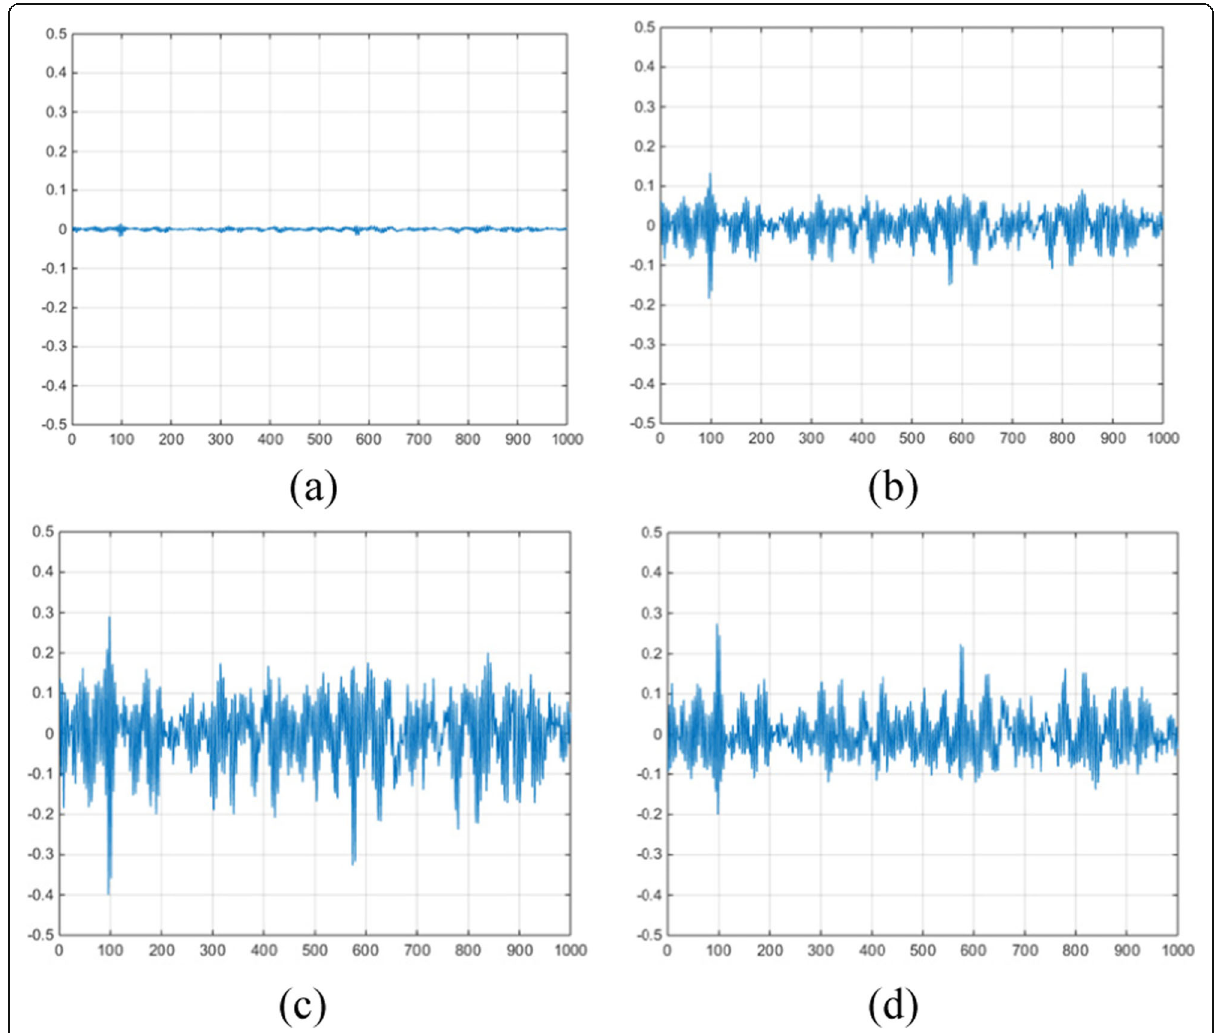
Fig. 5 Output signal at each beam-scanning grid (elevation, azimuth): a (10°, 20°), b (75°, 90°), c (45°, 180°), and d (65°, 310°)